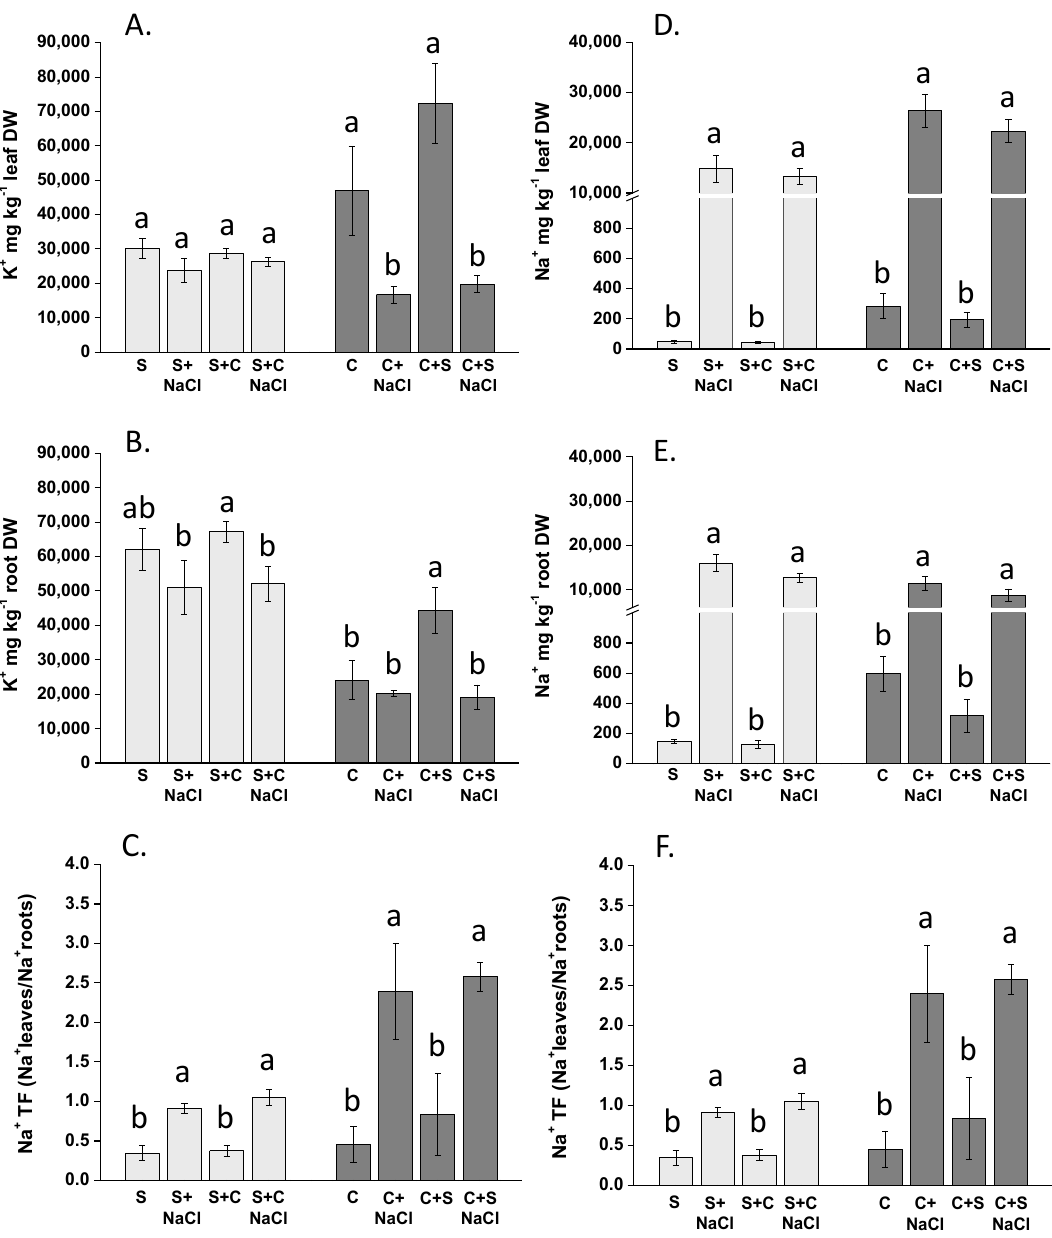
Figure 6. Na + content in leaves ( A ) and roots ( B ) of soybean and C. album , treated and nontreated with NaCl. ( C ) Na + translocation factor (TF) of soybean and C. album , treated and nontreated with NaCl. K + content in leaves ( D ) and roots ( E ) of soybean and C. album , treated and nontreated with NaCl. ( F ) K + translocation factor (TF) of soybean and C. album , treated and nontreated with NaCl. Different letters within each group of bars indicate significant differences at p < 0.05, n = 3. S = soybean; C = C. album. The experiment was replicated twice, and only data from one representative experiment are shown.